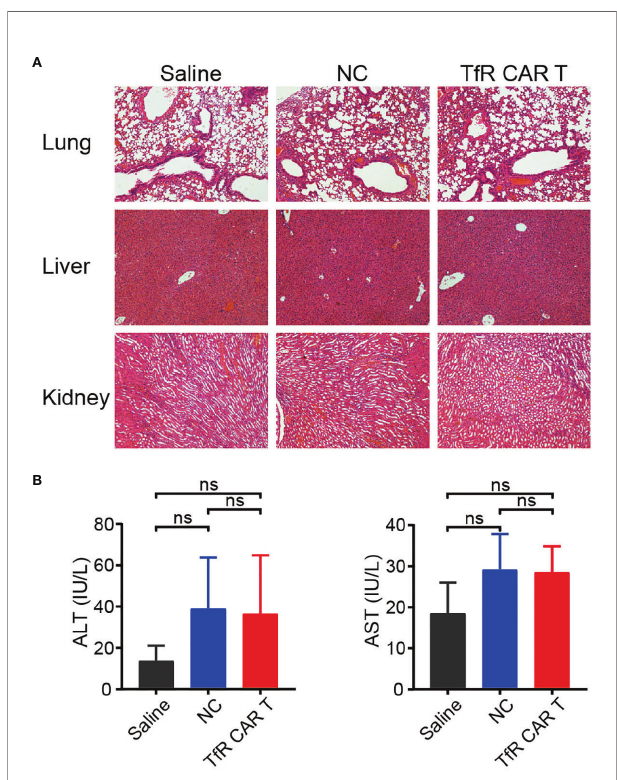
FIGURE 6 | The safety evaluation of TfR-CAR T cell therapy. (A) H&E staining of the major tissues, including lung, liver, and kidney. Images were captured under 100× magni fi cation. (B) Levels of plasma AST and ALT. n = 4 per cohort. All data are presented as means ± SD. ns indicates no statistical